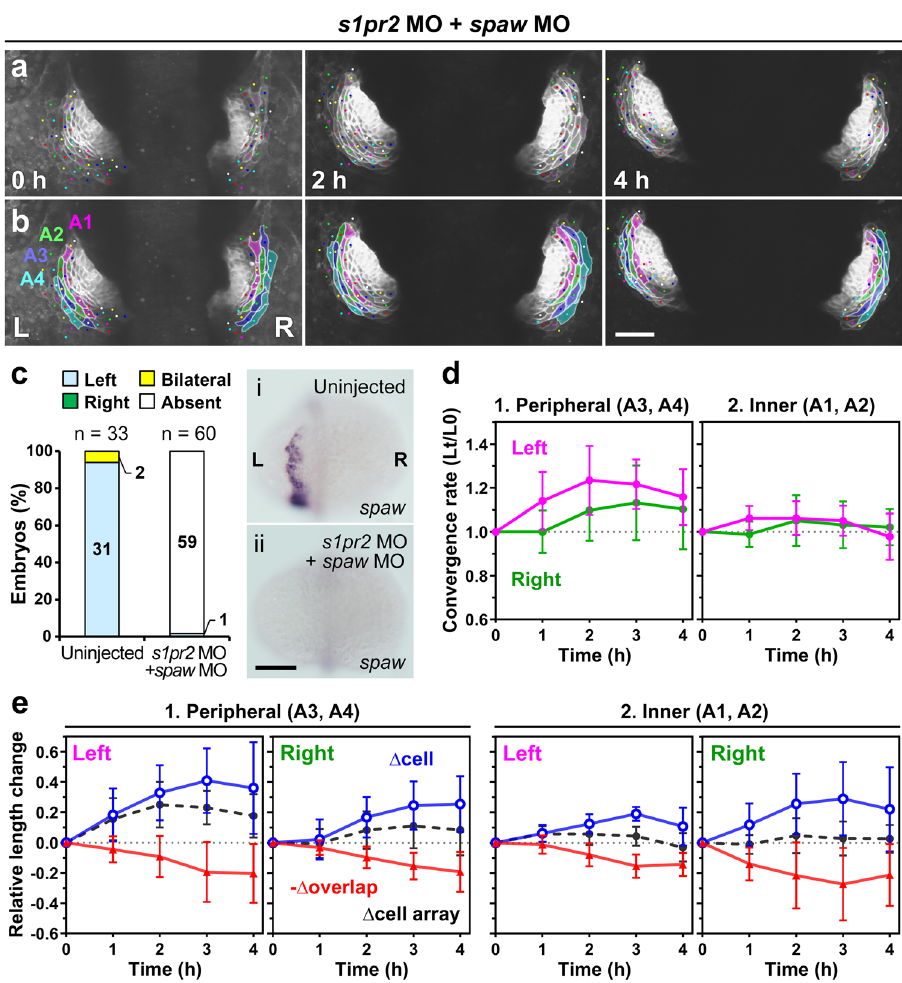
Fig. 8 Nodal signaling regulates asymmetric convergence of the left and right heart primordia. a , b Loss of Nodal signaling abolished asymmetric convergence of the left (L) and right (R) primordia in cardia bi fi da. a Selected images from a confocal time-lapse recording of a Tg(myl7:EGFP-CAAX) ncv536Tg embryo co-injected with spaw MO and s1pr2 MO starting at 19 – 20 hpf (Supplementary Movie 8). Ventral view (anterior to the top). The images were horizontally fl ipped to be presented in a consistent left-right orientation with other images. b Colored, corresponding images to those in a . Four cell arrays are labeled with different colors (A1 – A4). Scale bar = 50 µ m. c spaw mRNA expression in uninjected (i) and MO-injected (ii) embryos was assessed by in situ hybridization. The bar graph shows percentage of control (uninjected siblings, n = 33), and spaw MO and s1pr2 MO co-injected embryos ( n = 60) with left- sided, right-sided, bilateral, or absence of spaw expression in the lateral plate mesoderm (LPM). Morpholino injection abolished spaw expression in the LPM. Scale bar = 200 µ m. d Plots of the relative lengths (Lt/L0) of peripheral (1) and inner (2) cell arrays in spaw and s1pr2 double morphants. In embryos injected with both spaw MO and s1pr2 MO, left myocardial cell arrays did not exhibit the more rapid convergence unlike morphants injected with only s1pr2 MO shown in Fig. 6. No signi fi cant left-right difference was found in both the peripheral and inner cell arrays (two-tailed t -test assuming unequal variances, n = 3 embryos). Means ±s.d. are shown. e Relative length changes of cell arrays (black), cells (blue), and loss of the cell lengths caused by the cell overlap (red) in the peripheral (1) and inner (2) cell arrays in spaw and s1pr2 double morphants. Cell length in the morphants was markedly increased in both left and right cells. n = 3 embryos. In one out of these three embryos, only A2 – A4 cell arrays were analyzed because accurate measuring was dif fi cult in A1 cell arrays of this embryo. Means ±s.d. are shown. For d , e , corresponding graphs indicating individual data points are shown in Supplementary Fig.